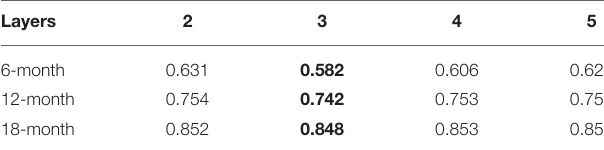
TABLE 3 | Root Mean Square Error (RMSE) of lead times with different